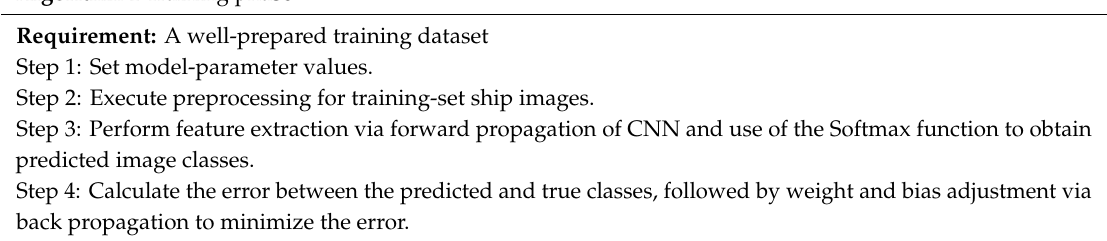
Algorithm 1 Training